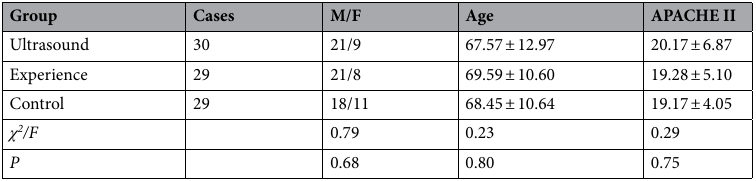
Table 1. Characteristics of the study population. One patient in the experience group had gastrointestinal bleeding, and one patient in the control group discontinued treatment. Two patients were excluded from the statistical